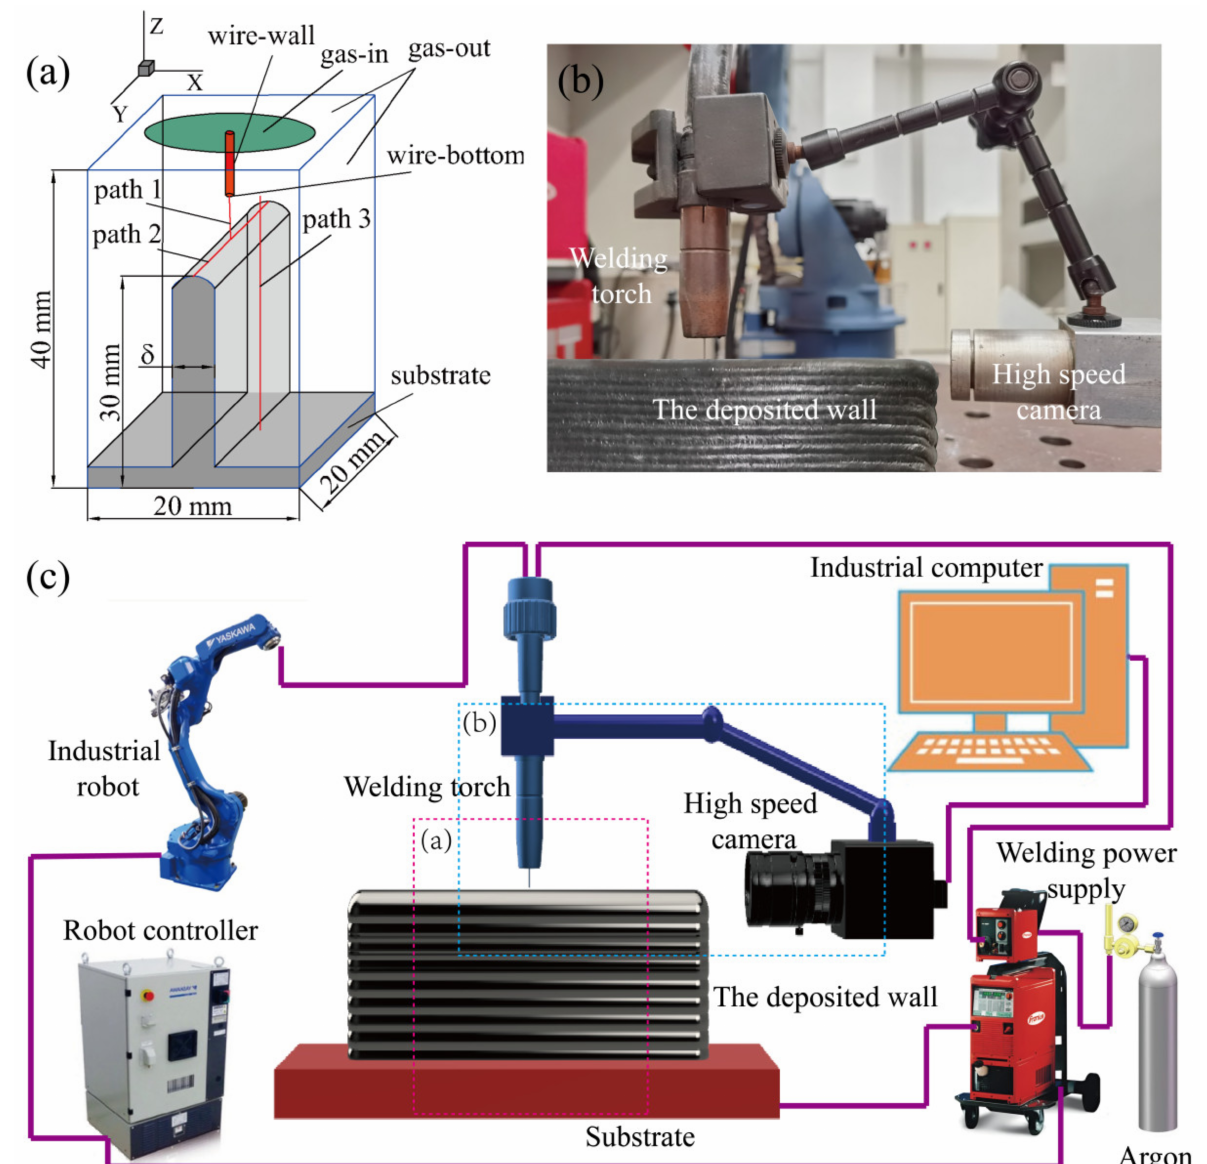
Figure 1. The schematic diagram of the single-pass multi-layer WAAM experiments: ( a ) the single-pass multi-layer WAAM system; ( b ) the computational domain and boundary conditions; ( c )